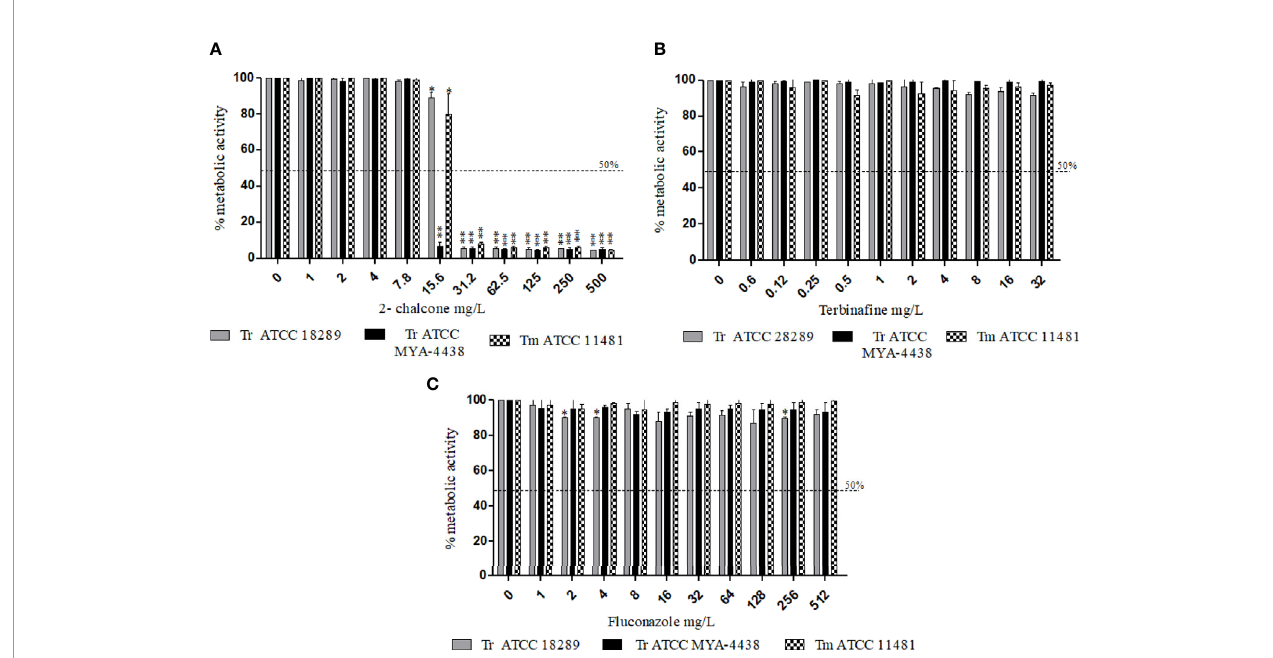
FIGURE 2 | Effect of 2-chalcone (A) , terbina fi ne (B) , and fl uconazole (C) on mature bio fi lms of T. rubrum ATCC 28189, T. rubrum ATCC MYA-4438, and T. mentagrophytes ATCC 11481 measured by the XTT reduction assay. Only 2-chalcone showed action against mature bio fi lms from a concentration of 31.2 mg/L. On the contrary, bio fi lms formed by all tested strains were resistant to the drugs terbina fi ne and fl uconazole even at the highest concentrations (*p < 0.05; **p < 0.001). Tr- T. rubrum , Tm- T. mentagrophytes